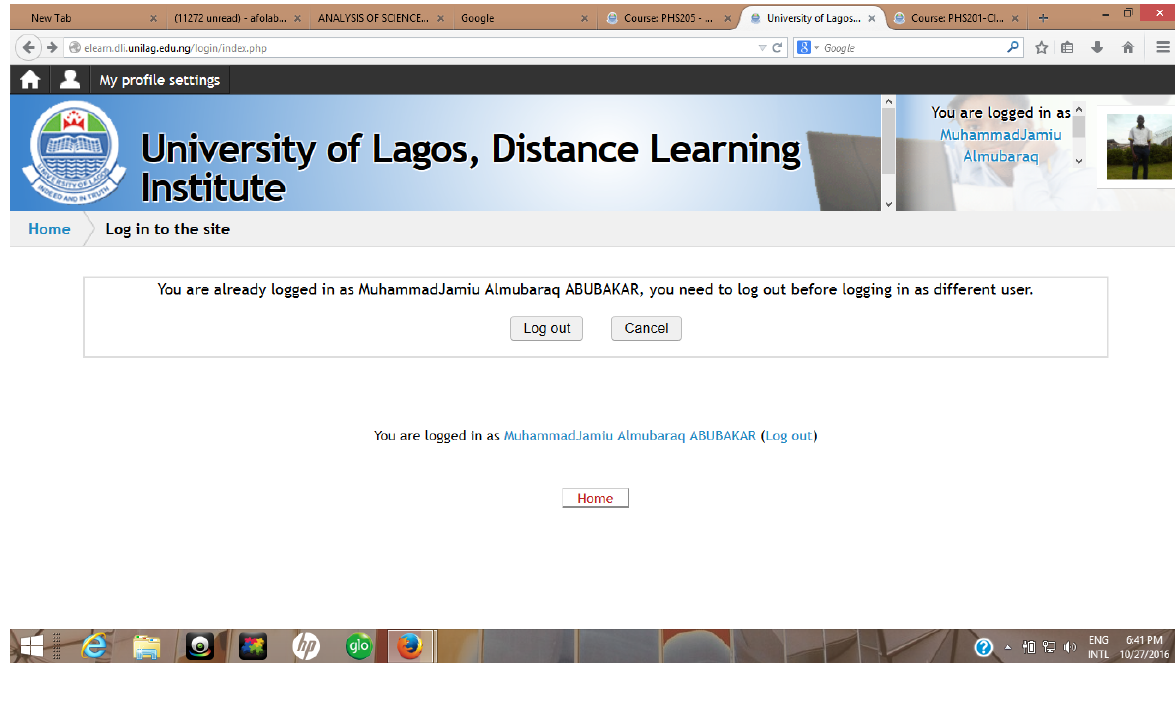
Figure 2. Student login page (screen shot).